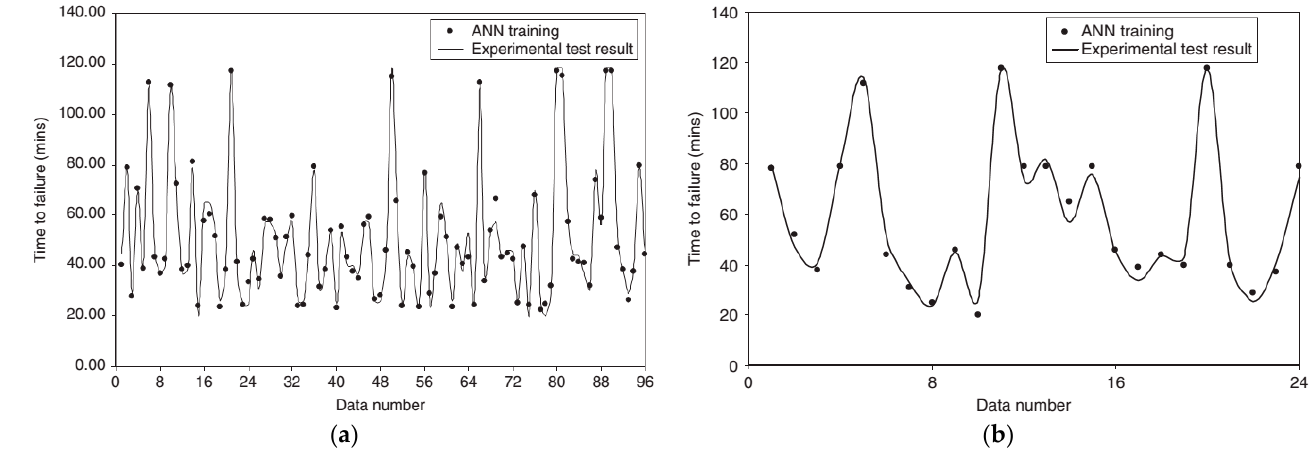
Figure 2. Comparison of experimental data and an artificial neural network (ANN) model to predict the failure time of concrete columns on a ( a ) training set and ( b ) test set. Adapted with permission from ref. [70]. Copyright 2014 Journal of Structural Fire Engineering.